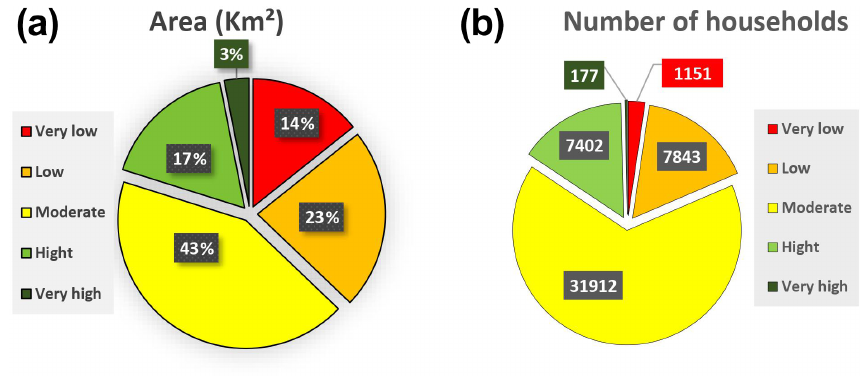
Figure 8. (a) Total flood resilience score distribution according to the surface of the study area; (b) total flood resilience score distribution according to household numbers in the study